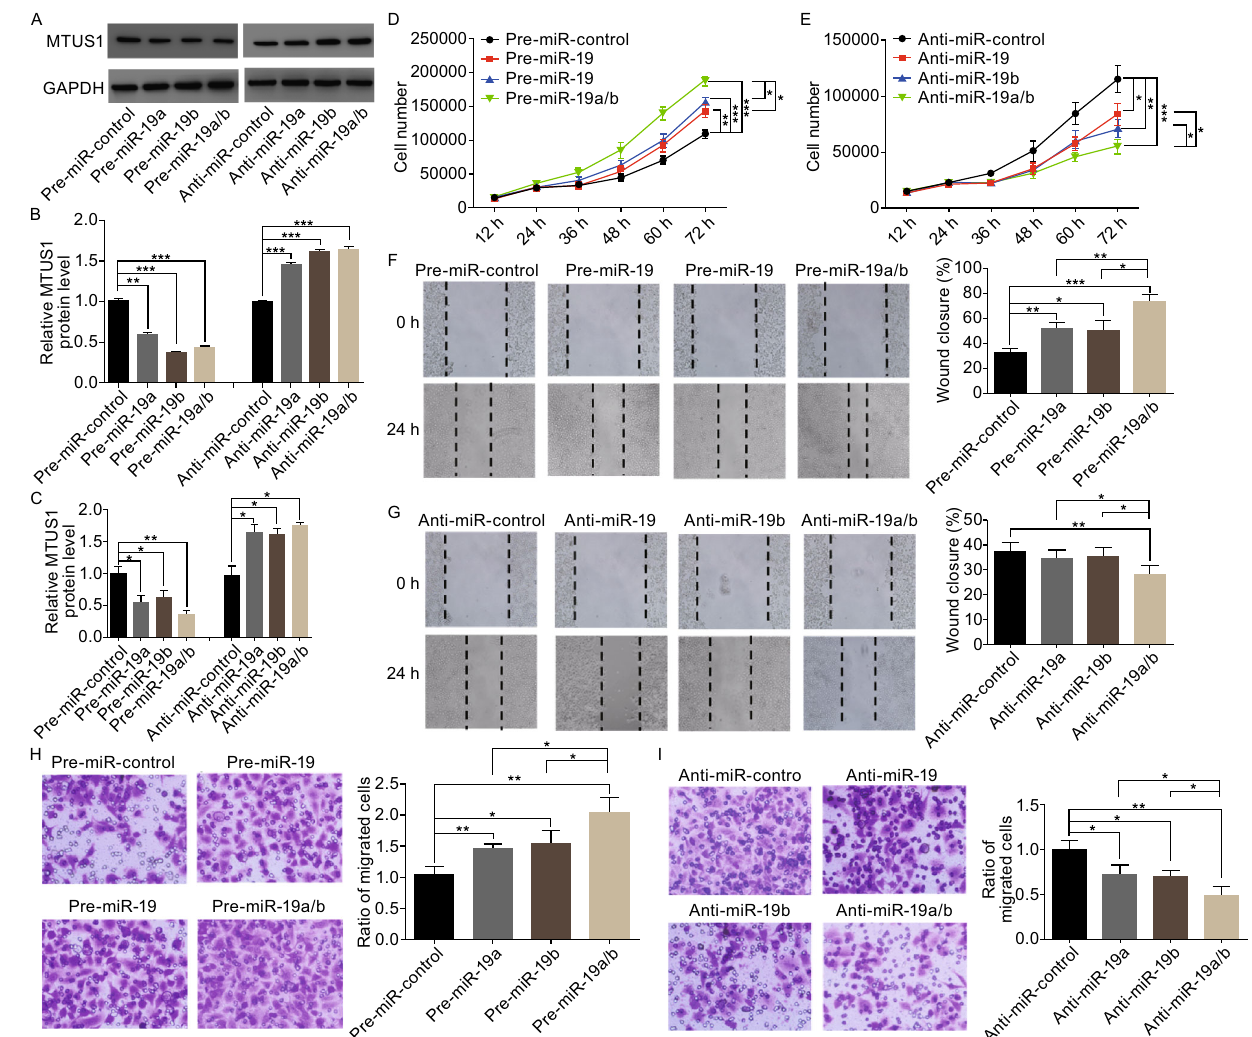
Figure 4. Effects of miR-19a/b on lung cancer cell proliferation and migration. (A and B) Western blot analysis of MTUS1 protein levels in A549 cells transfected with equal amounts of pre-miR-control (100 pmol), pre-miR-19a (100 pmol), pre-miR-19b (100 pmol) or pre-miR-19a/b (50 pmol each) or equal amounts of anti-miR-control (100 pmol), anti-miR-19a (100 pmol), anti-miR-19b (100 pmol) or anti-miR-19a/b (50 pmol each). (A) Representative image; B: quantitative analysis. (C) Quantitative RT-PCR analysis of MTUS1 mRNA levels in A549 cells transfected with equal amounts of pre-miR-control (100 pmol), pre-miR-19a (100 pmol), pre-miR- 19b (100 pmol) or pre-miR-19a/b (50 pmol each) or equal amounts of anti-miR-control (100 pmol), anti-miR-19a (100 pmol), anti-miR- 19b (100 pmol) or anti-miR-19a/b (50 pmol each). (D and E) CCK-8 viability assays were performed 12, 24, 36, 48, 60, and 72 h after transfection of equal amounts of pre-miR-control (100 pmol), pre-miR-19a (100 pmol), pre-miR-19b (100 pmol) or pre-miR-19a/b (50 pmol each) or equal amounts of anti-miR-control (100 pmol), anti-miR-19a (100 pmol), anti-miR-19b (100 pmol) or anti-miR-19a/b (50 pmol each) into A549 cells. (F and G) Wound healing assays were performed 24 h after transfection of equal amounts of pre-miR- control (100 pmol), pre-miR-19a (100 pmol), pre-miR-19b (100 pmol) or pre-miR-19a/b (50 pmol each) or equal amounts of anti-miR- representative image; right panel: quantitative analysis of wound closure rates. (H and I) Transwell assays were performed 24 h after transfection of equal amounts of pre-miR-control (100 pmol), pre-miR-19a (100 pmol), pre-miR-19b (100 pmol) or pre-miR-19a/b (50 pmol each) or equal amounts of anti-miR-control (100 pmol), anti-miR-19a (100 pmol), anti-miR-19b (100 pmol) or anti-miR-19a/b (50 pmol each) into A549 cells. Left panel: representative image; right panel: quantitative analysis. *, P < 0.05; **, P < 0.01; ***, P <